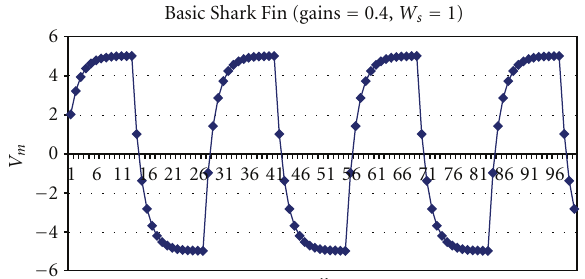
Figure 4: Output of the basic Shark Fin neural oscillator. Here, the waveform is continuous and non-diminishing.